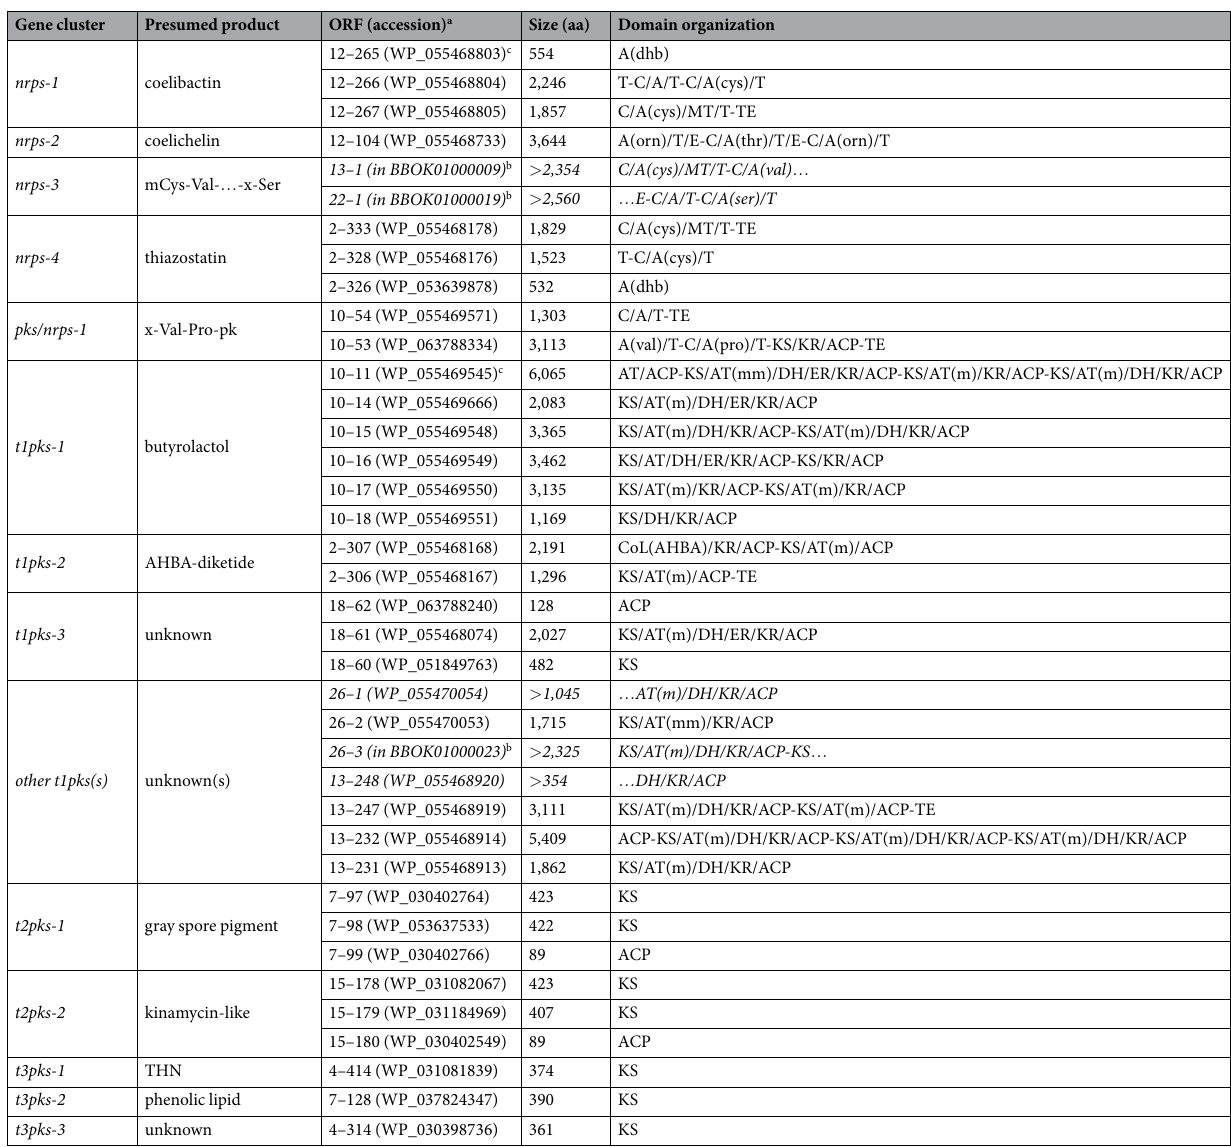
Table 2. Open reading frames (ORFs) encoding nonribosomal peptide synthetases (NRPSs) and polyketide synthases (PKSs) in NRPS and PKS gene clusters from Streptomyces sp. TP-A0882 (NBRC